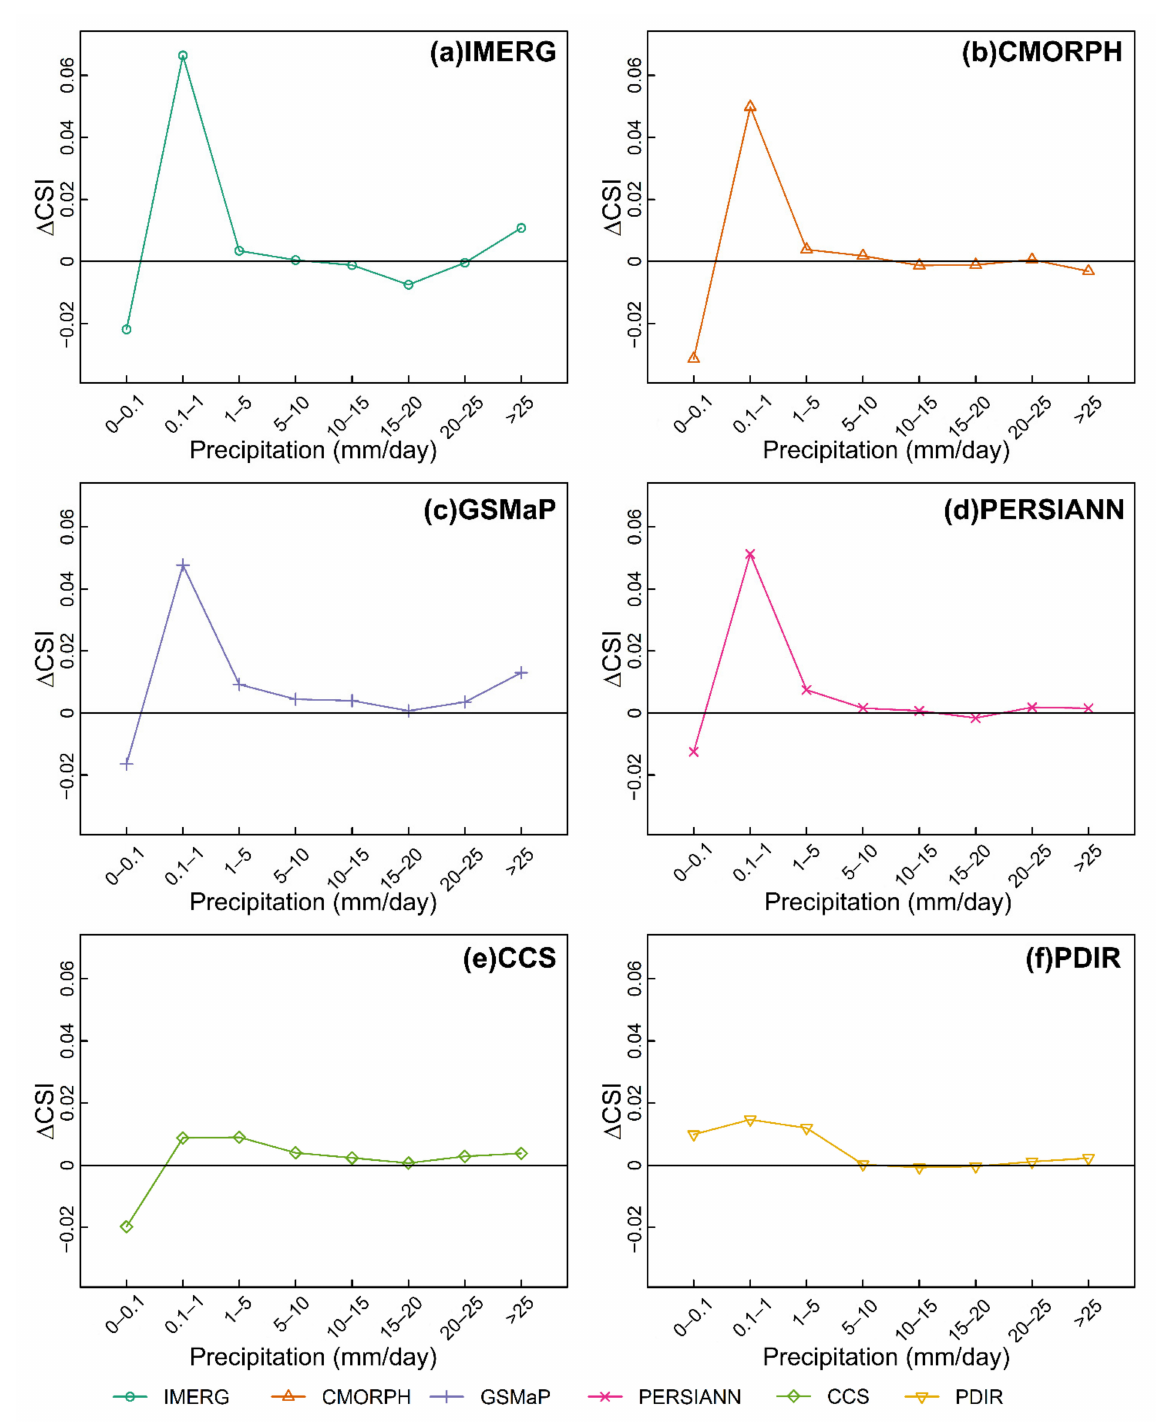
Figure 7. The changes of ∆ CSI in different ranges of precipitation intensity for ( a ) IMERG, ( b ) CMORPH, ( c ) GSMaP, ( d ) PERSIANN, ( e ) CCS, and ( f )